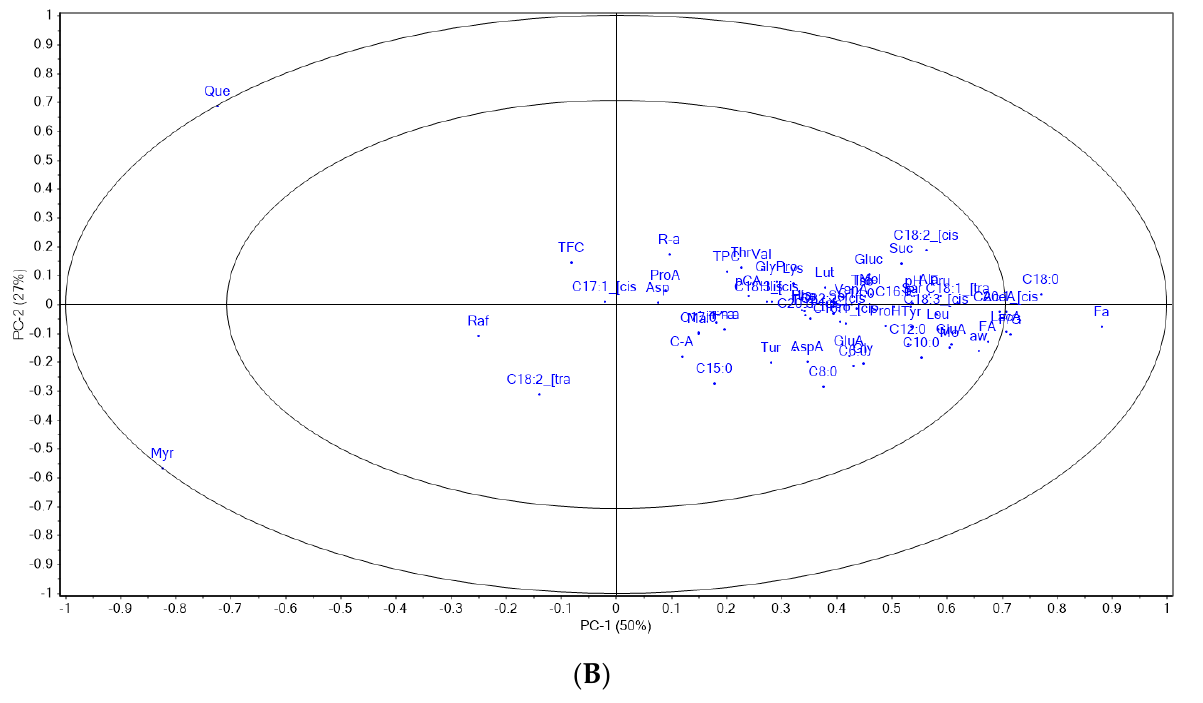
Figure 2. Principal component analysis scores ( A ) and loadings ( B ) of the bee pollen based on their physicochemical, organic acids, sugars, TPC, TFC, phenolics compounds, amino acids, fatty acids: a — scores, b — loadings, Fa-free acidity, Mo — moisture content, Fa-lipids, p-protein content, Fru- fructose, Glu-glucose, Suc-sucrose, Tur-turanose, Mal-maltose, Tre-trehalose, Mel-melesitose, Raf- raffinose, GluA-gluconic acid, LacA-lactic acid, AceA-acetic acid, ProA- propionic acid, TPC-total phenolic content, TFC-total flavone content, p-a — protocatecuic acid, 4-h-a — p-hydroxibenzoic acid, C-a — chlorogenic acid, p-c-A — p-coumaric acid, R-a — rosmarinic acid, V-A vanillic acid, Ala-ala- nine, Sar-Sarcosine, Gly-glicine, Val-valine, Leu-leucine, Iso — isoleucine, Thr-threonine, Ser-Serine,